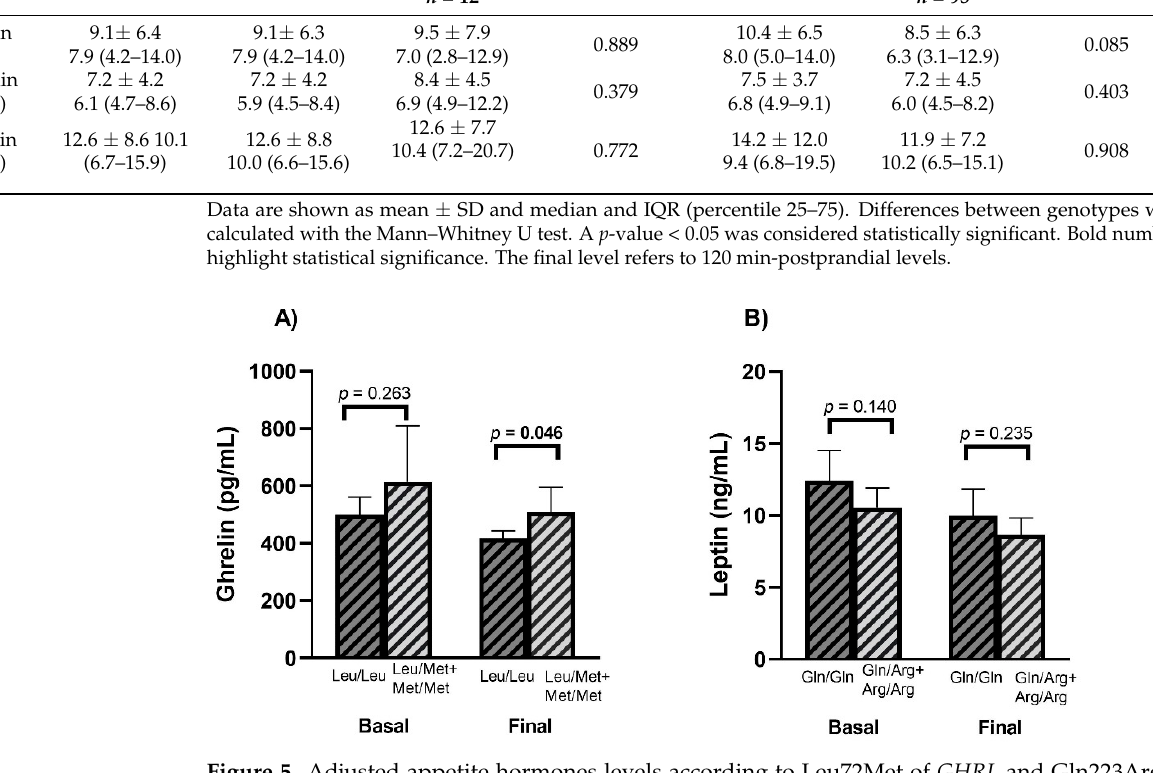
Figure 5. Adjusted appetite hormones levels according to Leu72Met of GHRL and Gln223Arg of LEPR . Graph ( A ) shows ghrelin concentrations between Leu72Met genotypes at fasting (basal) and at 120 minutes postprandial. Graph ( B ) shows leptin concentrations between Gln223Arg genotypes at fasting (basal) and at 120 minutes postprandial. Data are shown as estimated mean and 95% CI. ANCOVA (analysis of variance) test was used to compare appetite hormones between geno- types. Basal levels of ghrelin and leptin were adjusted by sex, body fat percentage, and percentage of carbohydrates, final levels of ghrelin and leptin (at 120 min postprandial) were adjusted by sex, body fat percentage, and percentage of carbohydrates, as well as for basal ghrelin and basal leptin, respectively. In all models, Bonferroni correction for multiple comparisons was used. A p -value < 0.05 was considered statistically significant. Bold numbers highlight statistical